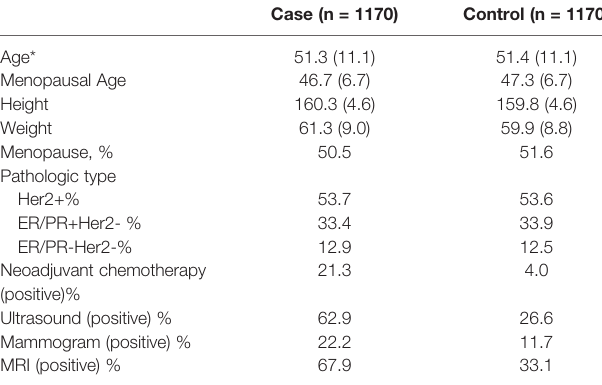
TABLE 1 | Baseline characteristics of study